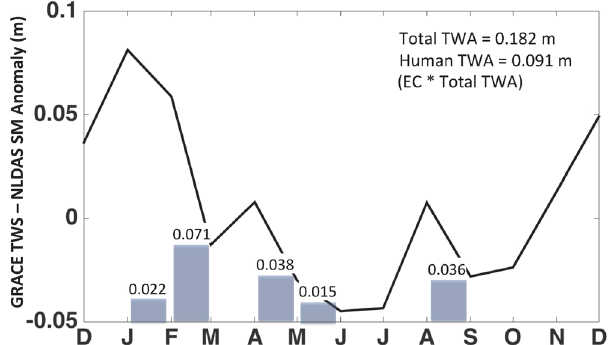
Figure 2. Conceptual diagram demonstrating how to calculate annual TWA. The black line represents the difference in monthly GRACE TWS and NLDAS soil moisture anomalies. The annual TWA is estimated as the cumulative decrease in month-to-month TWS and soil moisture differences (grey bars). The human TWA represents the portion of the total water available to humans after accounting for environmental demands using the environmental coefficient value, which is set to 0.5 in this